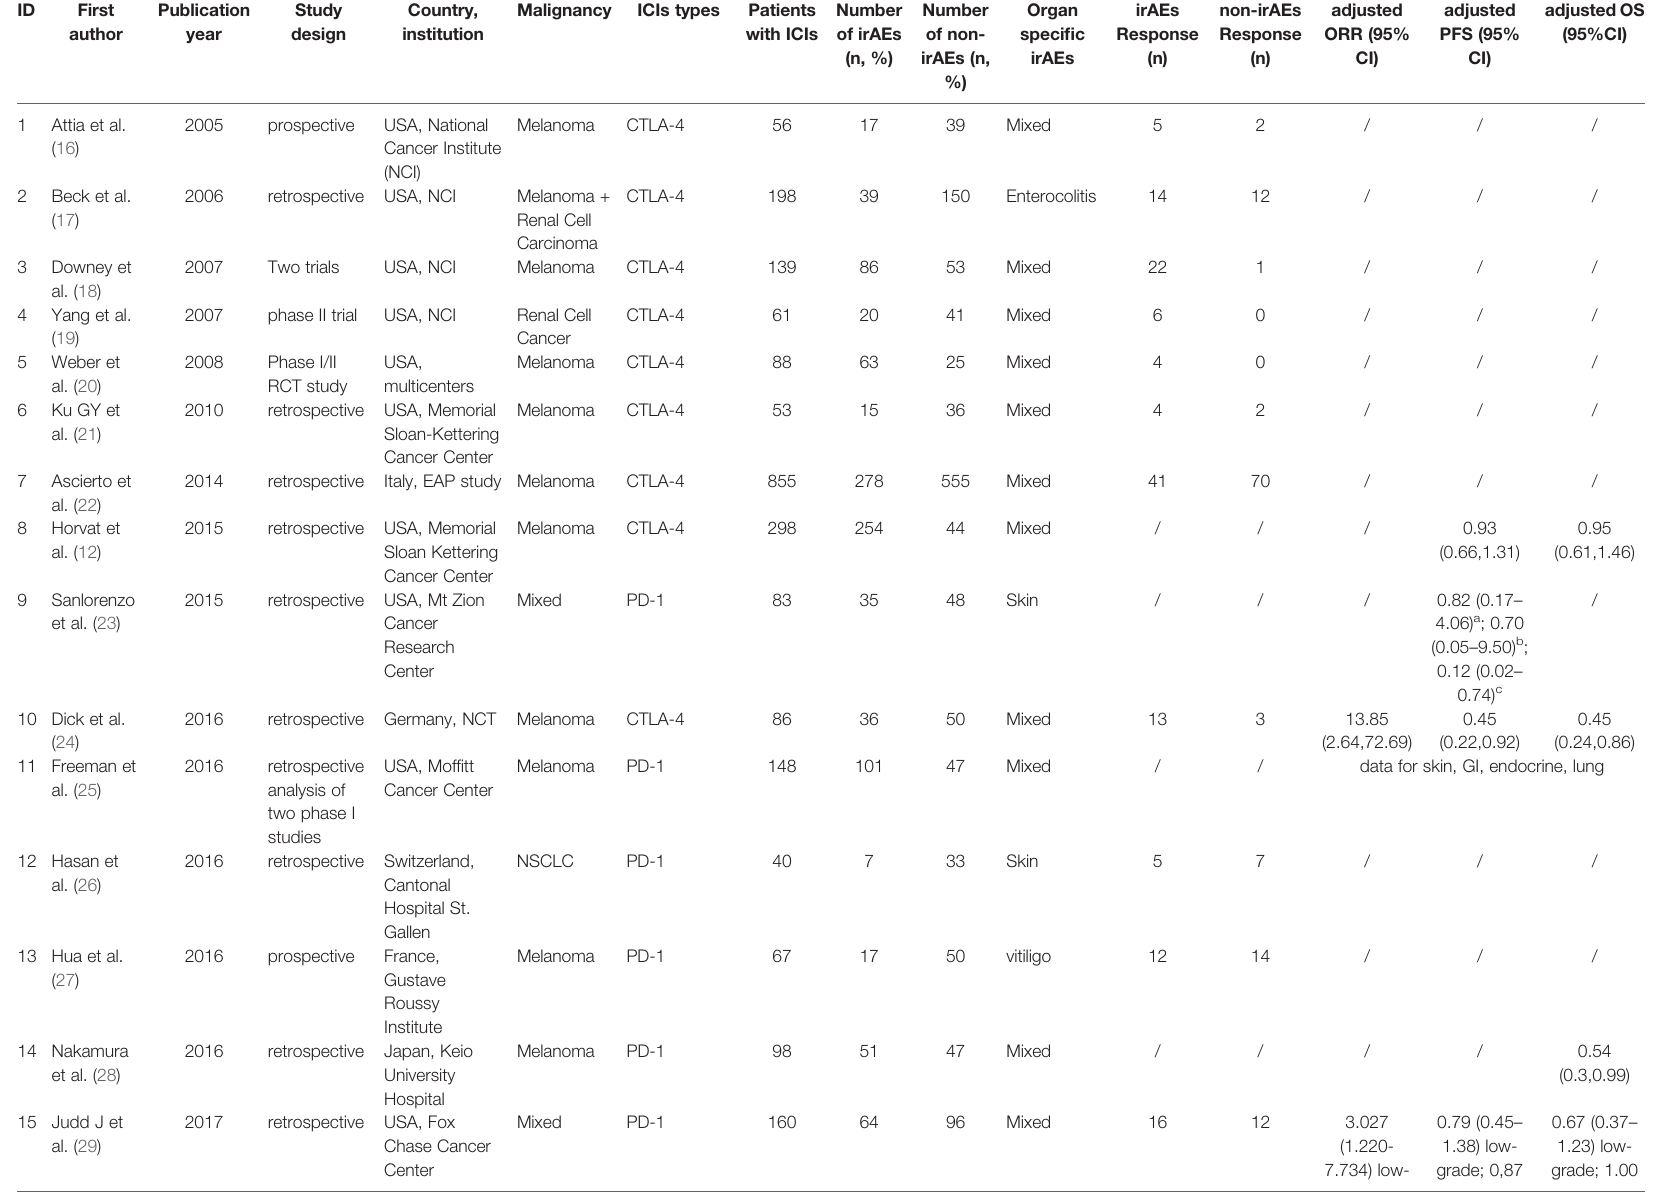
TABLE 1 | Characteristics and end-points (ORR, PFS, OS) of enrolled